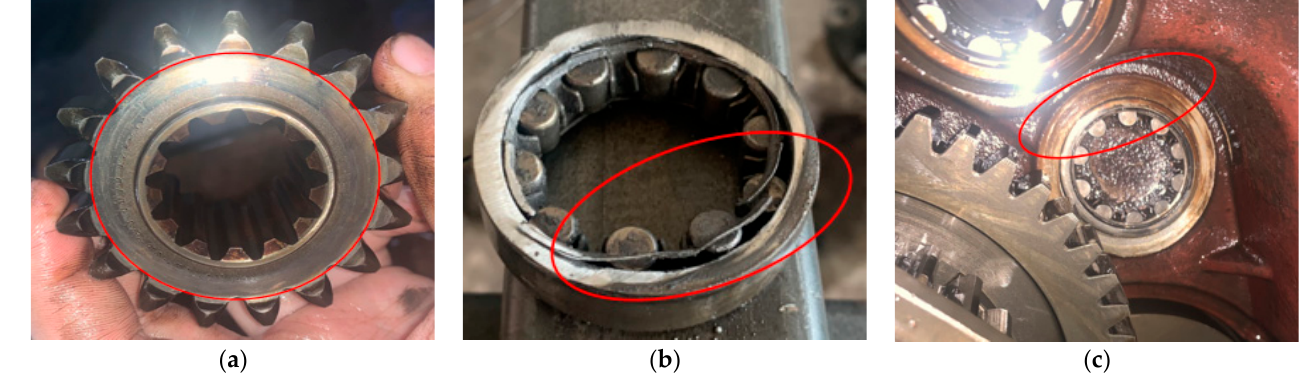
Figure 13. Internal damages of power shunt gear side ( a ), NJ205E cylinder roller bearing ( b ) and bearing hole wall ( c ).